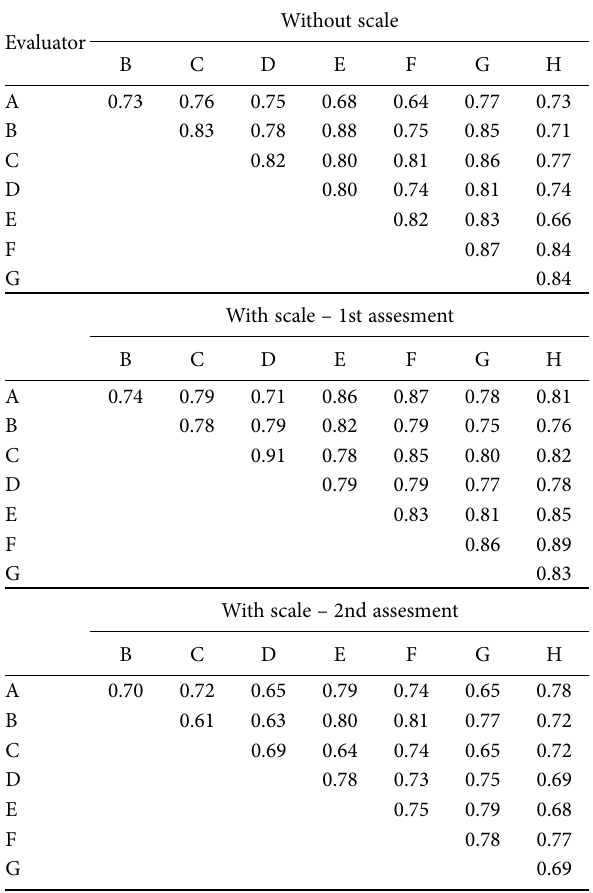
Table 4. Coefficients of determination (R²) of the linear regression equation between pairs of different evaluators, with or without the use of the disease severity assessment scale in two evaluations, esti- mating rust severity on fig leaves.